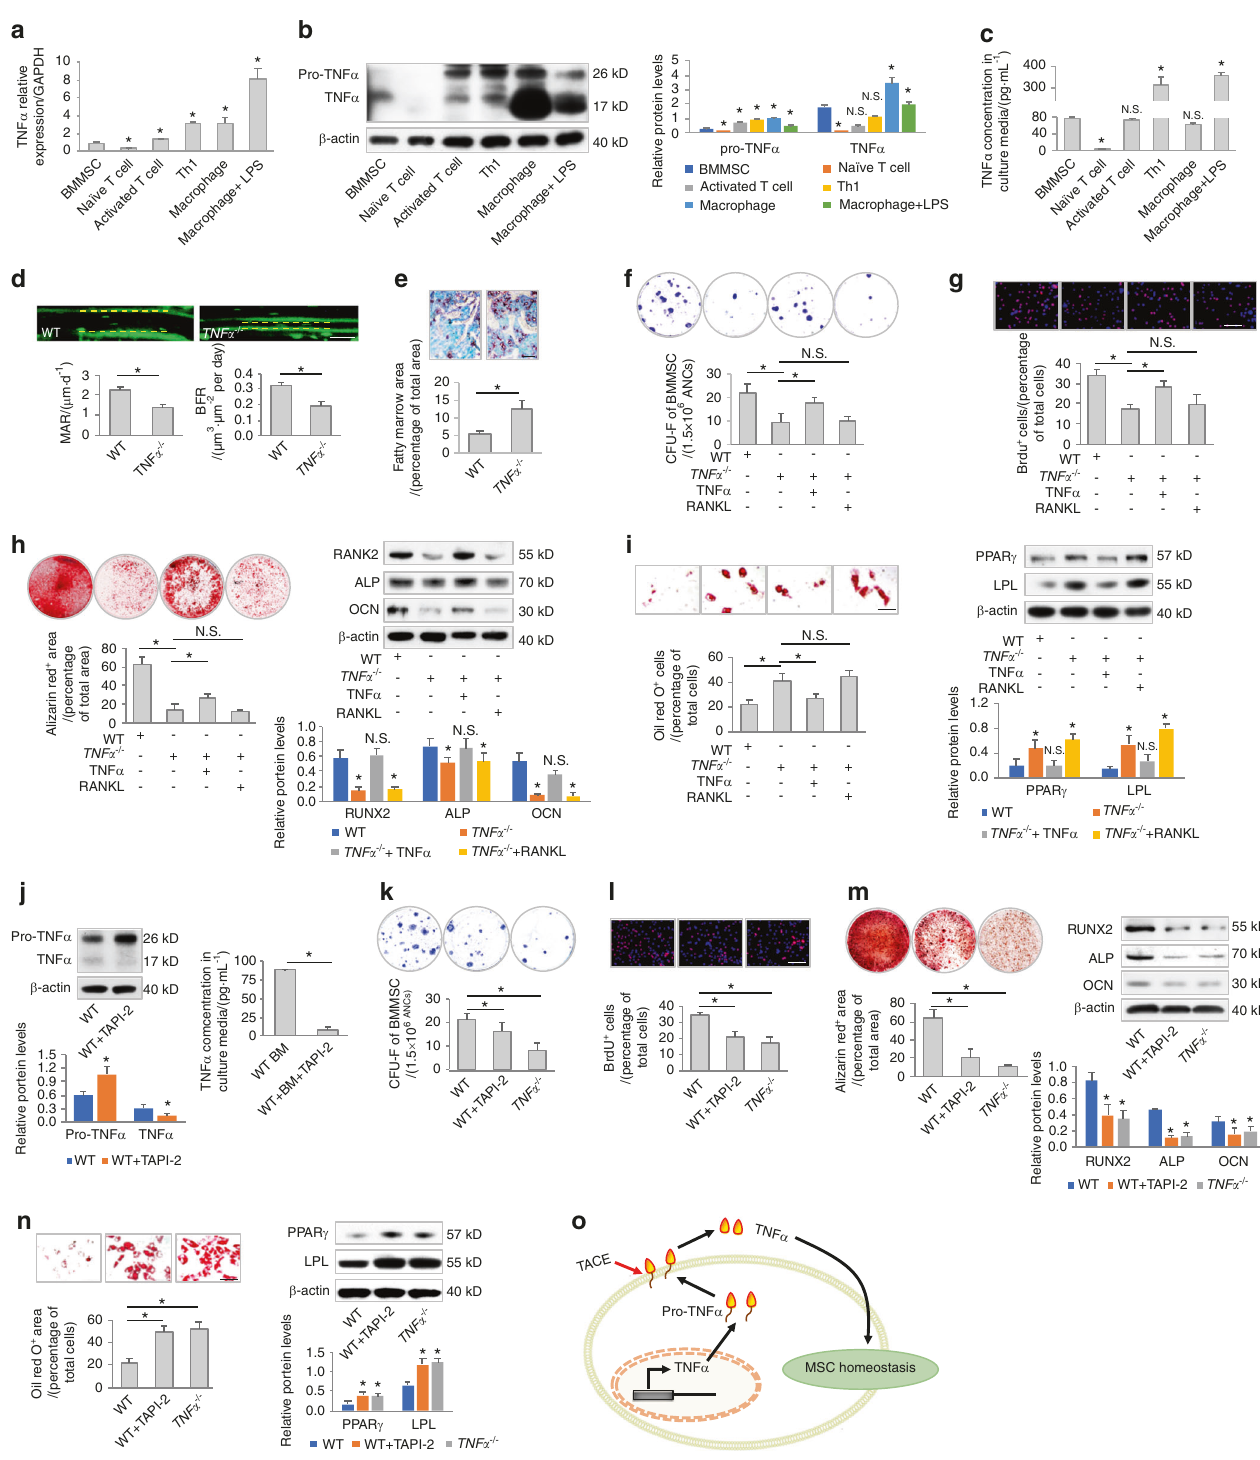
Fig. 1 MSCs produce and release TNF α for functional maintenance. a – c Examination of mRNA expression levels, protein expression levels, and secreted concentrations of TNF α in different cell types. N = 3. For quanti fi cation of Western blotting, two-tailed Student ’ s t test was used for comparisons between different cell types and MSCs. d Calcein labeling for bone formation analysis in WT and TNF α − / − mice ( N = 5). Scale bar = 50 μ m. e Oli red O staining for bone marrow adiposity in WT and TNF α − / − mice ( N = 5). Scale bar = 150 μ m. f – i Functional analyses of MSCs according to CFU, BrdU labeling, osteogenic, and adipogenic differentiation. TNF α and RANKL were added at 1 ng·mL − 1 . N = 5. Scale bars = 100 μ m. j Examination of protein expression levels and secreted concentrations of TNF α . N = 3. TAPI-2 was used to inhibit TACE at 120 nmol·L − 1 . k – n Functional analyses of MSCs according to CFU, BrdU labeling, and osteogenic and adipogenic differentiation. N = 3. Scale bars = 100 μ m. o Diagram showing the production and release of TNF α for the